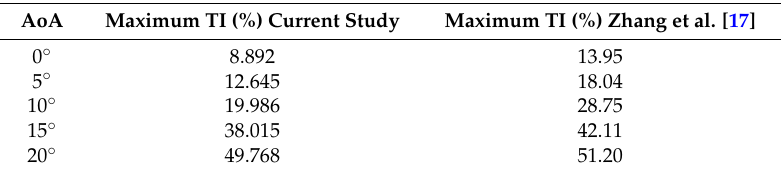
Table 6. Comparison of the maximum turbulence intensity (TI) at different incidence angles with the results of Zhang et al. [17].